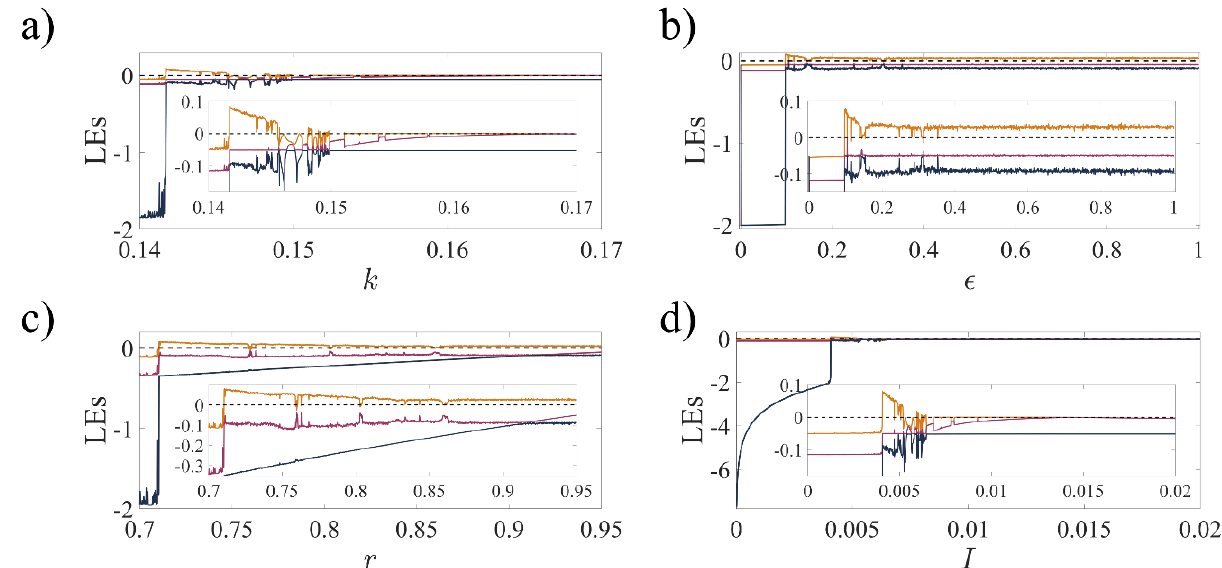
Figure 2. Two-parameter bifurcation diagram of 3D-MCM versus system parameters: ( a ) the magnetic strength, 𝑘 , and the injected ion current, 𝐼 ; ( b ) the scale factor of flux, 𝑟 , and the scale factor of time, 𝜖 . Excluding each bifurcation parameter in the panels, the other parameters are set, as mentioned in Table 1. Both diagrams are plotted for (𝑥(0), 𝑦(0), 𝜙(0)) = (1.0, 0.8, 0.2) .